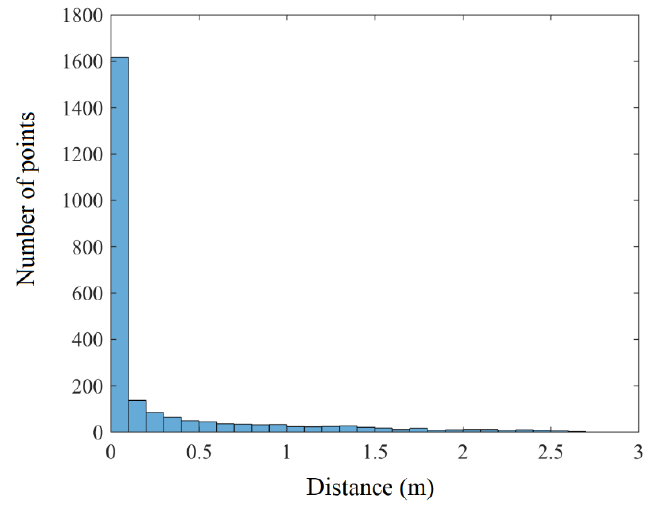
Figure 8. Histogram of deviations between cloud points and the 3D tower model. Table 1. Standard deviations and the number of points that deviate from the tower model within the specified intervals.